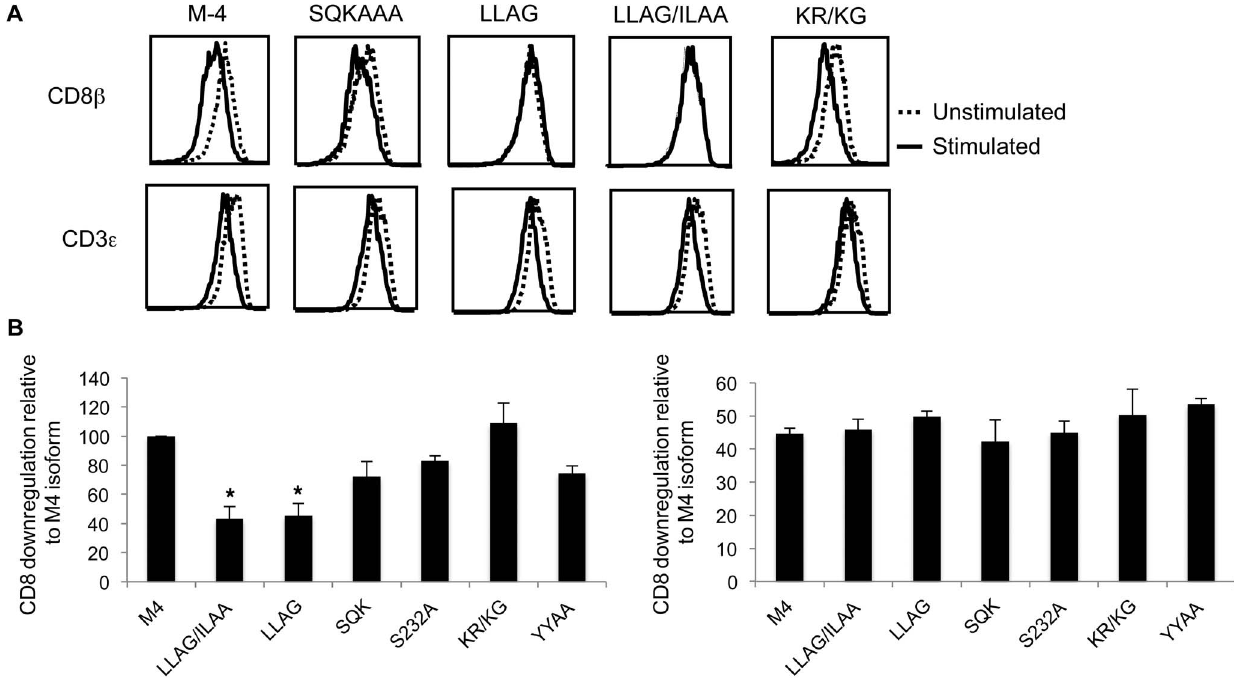
Figure 2. Identification of motifs signals in the cytoplasmic tail of M-4 isoform that modulate downregulation from the cell surface. ( A ) Receptor downregulation was measured by determining surface expression for CD8 b M-4 wild-type and M-4 mutant levels by flow cytometry before and after stimulation of cells with PMA (100 ng/ml) for 60 minutes. One representative of 3 independent experiments is shown. ( B ) Receptor downregulation relative to CD8 b M4 wild type was as in (A) quantitatively represented. Levels of CD3 protein after stimulation are indicated as well. Analyzing three experiments values that are statistically different from the wild type M-4 protein are indicated as * for p , 0.05 and ** p , 0.01.